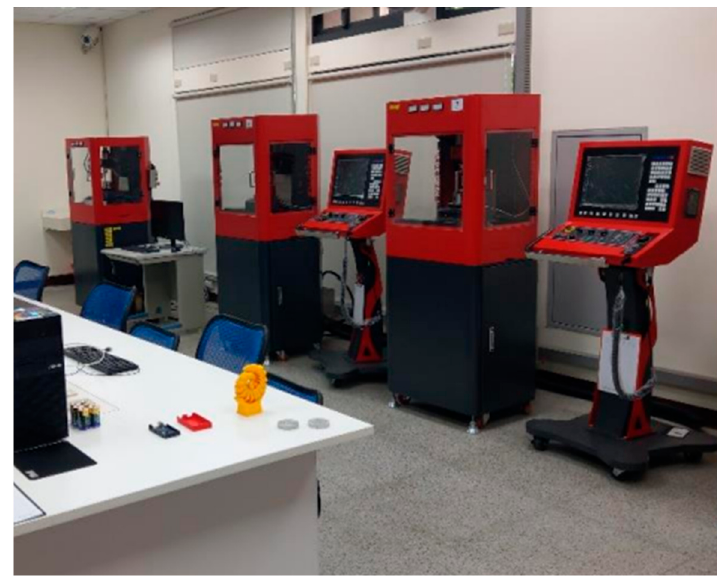
Figure 2. Audio recording environment.